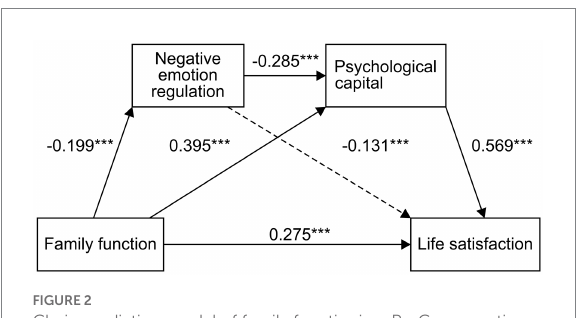
FIGURE 2 Chain mediation model of family functioning, PsyCap, negative emotion regulation strategy, and life satisfaction. *** is the marked path